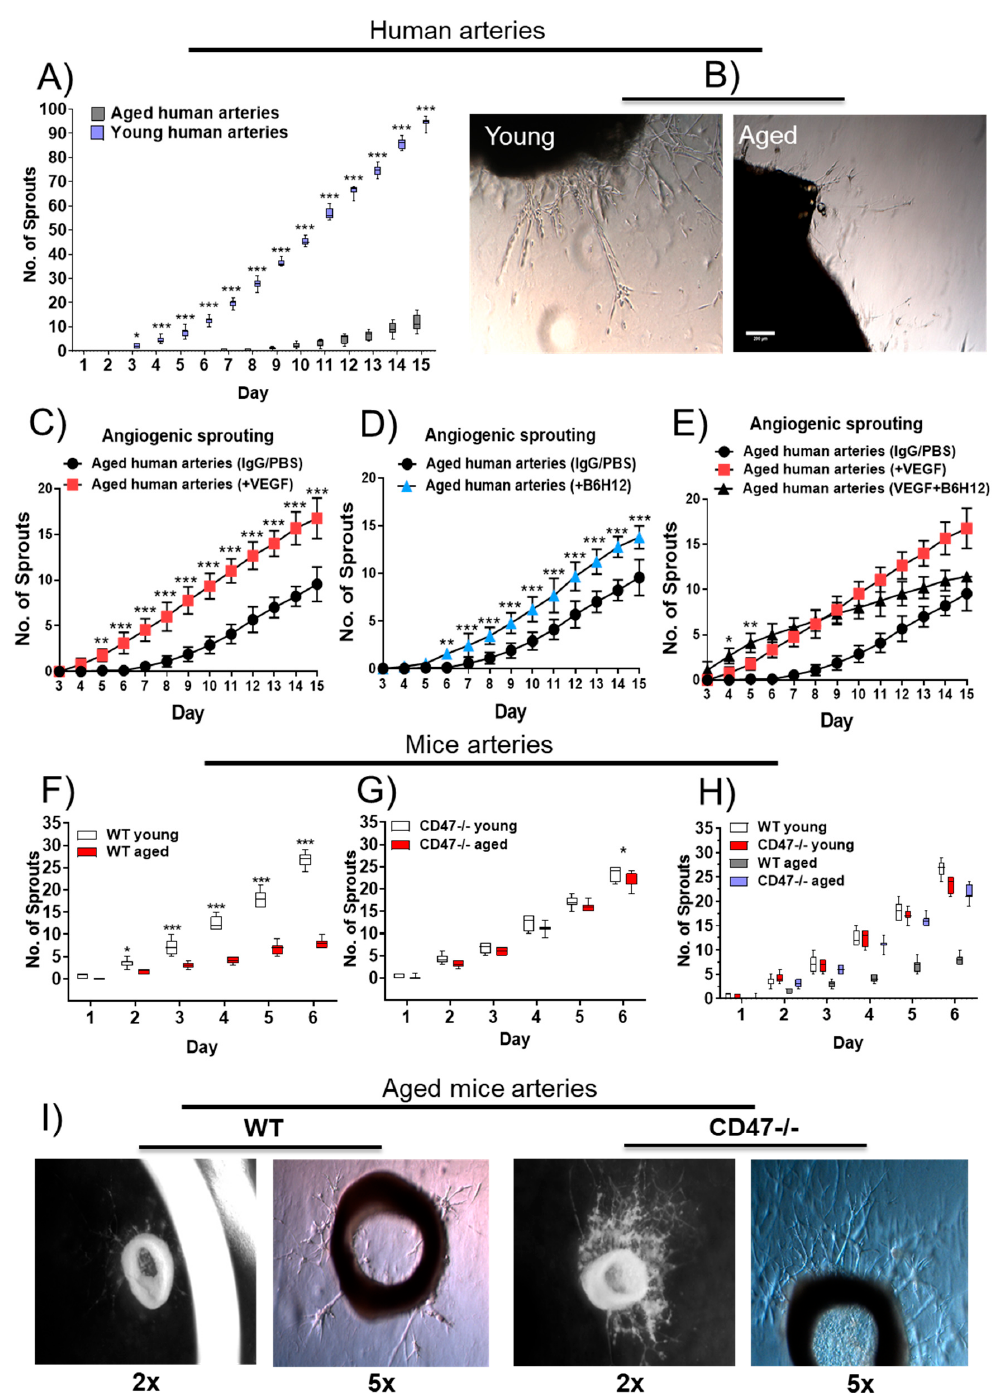
Figure 4. Sprouting angiogenesis in aged human and murine arterial rings is hindered by CD47. Quantification ( A ) and representative images ( B ) of sprouting of distal 5 th -order human superior mesenteric arteries from old ( > 60 years) and young ( < 33 years) individuals. Human arteries from old ( > 60 years) versus young ( < 33 years) individuals were cultured in the presence of VEGF (50 ng / mL) ( C ) or a human CD47 blocking antibody (clone B6H12, 2 µ g / mL) ( D ) or antibody + VEGF ( E ) and angiogenic sprouting quantified. Quantification of aortic sprouting from 3- and 18-month-old male wild-type (WT) and CD47-null mice ( F , G ), and side-by-side comparison ( H ), with representative images of aged mice artery sprouting ( I ). Scale bar: 200 µ m. Error bar represents the mean ± SEM, 3 wells / vessel, 3 subjects / group for human arteries and 3 wells / vessel and 3 mice / group. * p < 0.05, ** p < 0.01, *** p < 0.001; 1-way ANOVA, followed by a Tukey’s multiple comparison